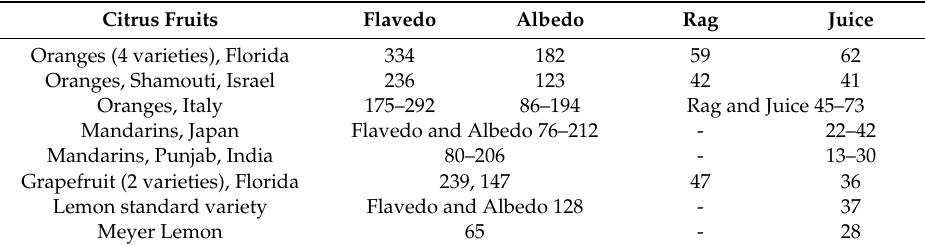
Table 11. Ascorbic acid composition in di ff erent parts of citrus waste (mg / 100 g) [21]. Citrus Fruits Flavedo Albedo Rag Juice Oranges (4 varieties),